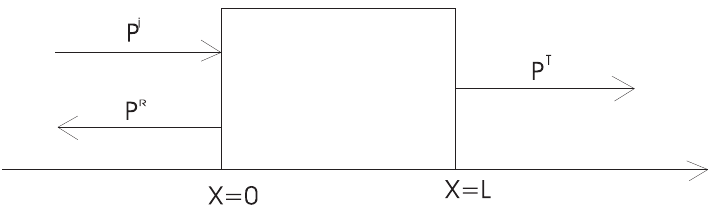
Figure 1. Geometry of the